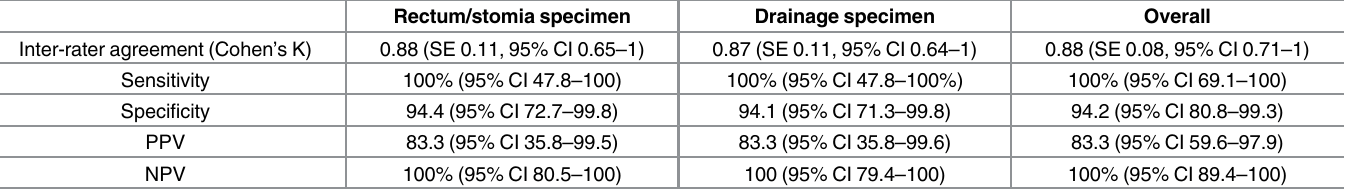
Table 4. Performance of Xpert Carba-R assay in comparison with microbiological culture for detection of carbapenem resistance when consider- ing only the 5 mechanisms of resistance (KPC, VIM, OXA-48, IMP-1, NDM) detected by both